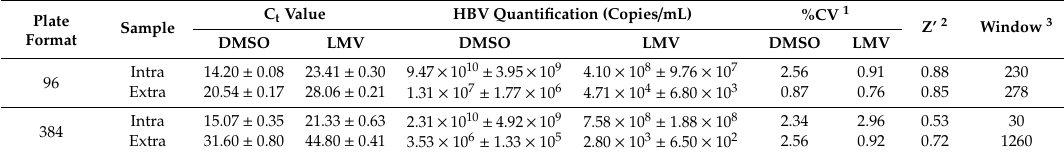
Table 2. Evaluation of assay performance in microtiter